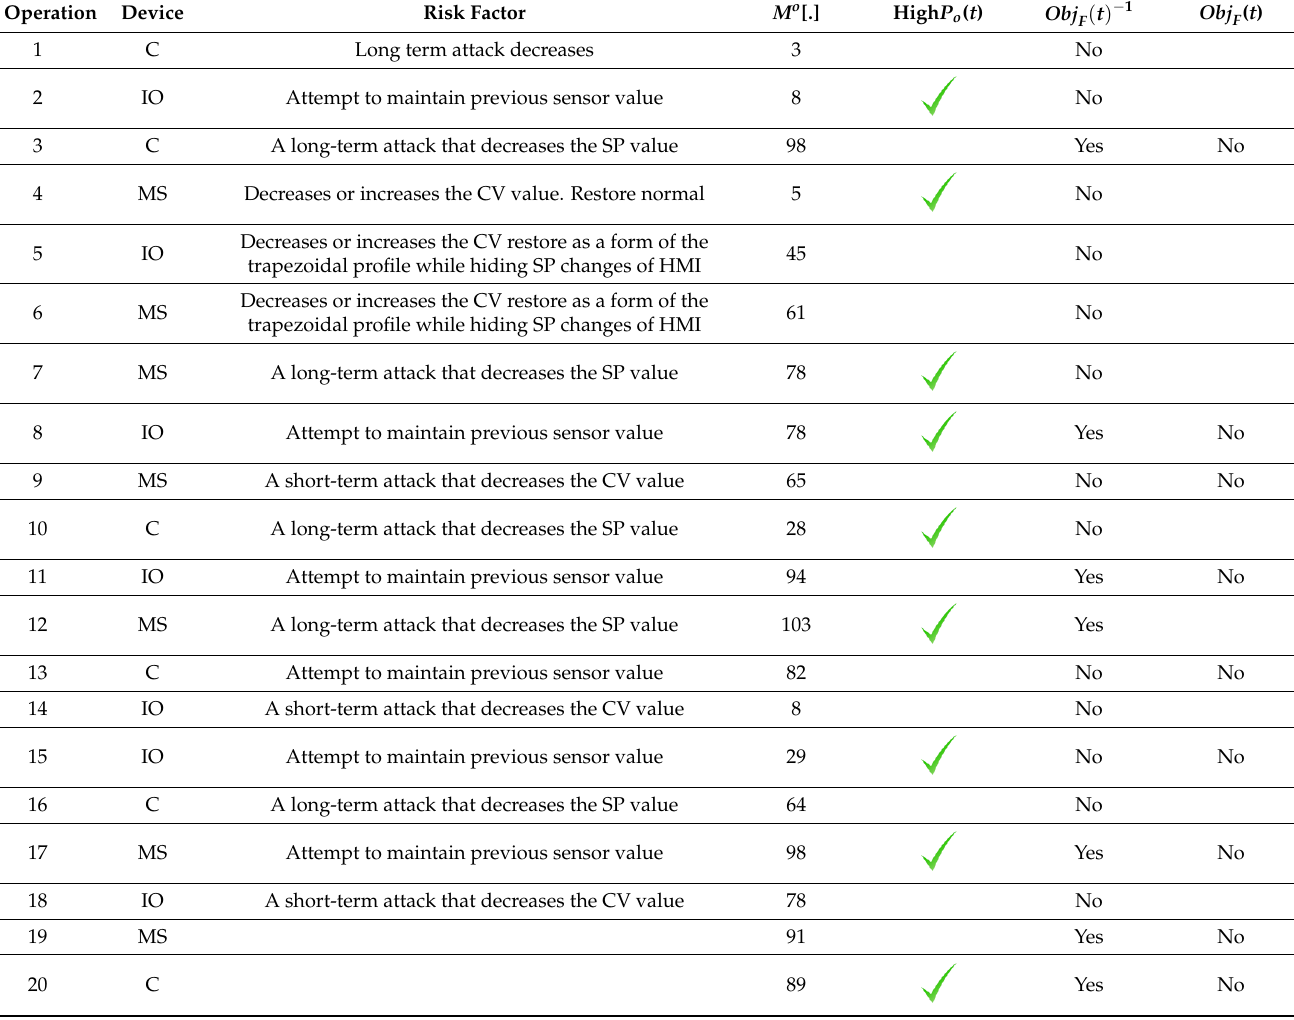
(𝑖, 𝑗) 𝑓𝑢𝑧𝑧𝑦 𝑜𝑝𝑡 𝑖,𝑗 wherein (𝑡) and 𝐼 (𝑡) as in Equation 𝑜 𝐻